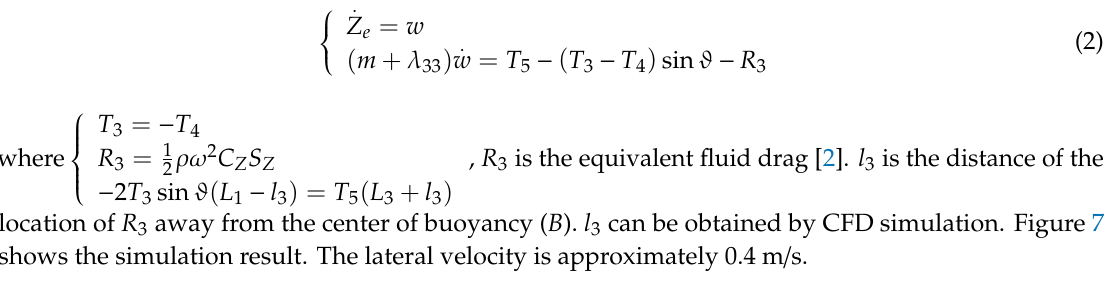
Figure 5. Simulation turning radius at different speed.